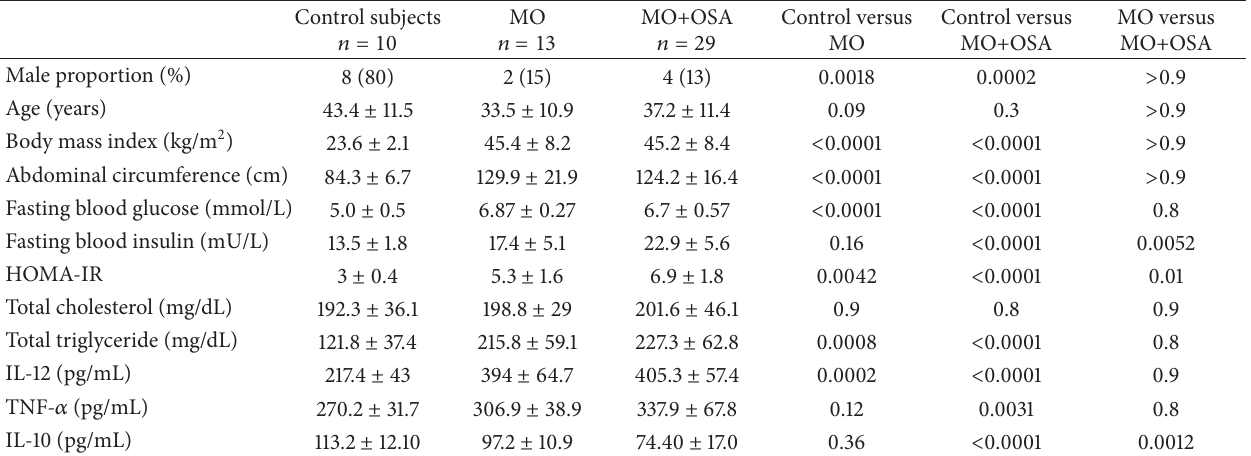
Table 1: Anthropometric, biochemical, and immunological characteristics of the study